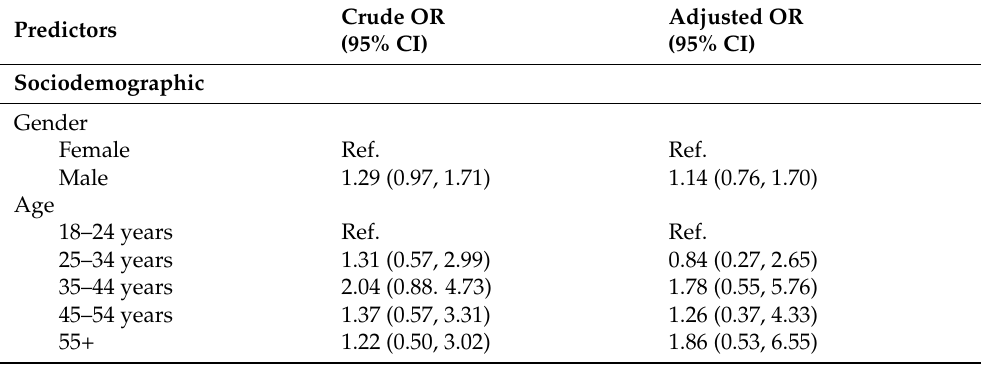
Table 2. The regression models predicting anti-vaccine † attitudes, Non-Representative National sample, N =